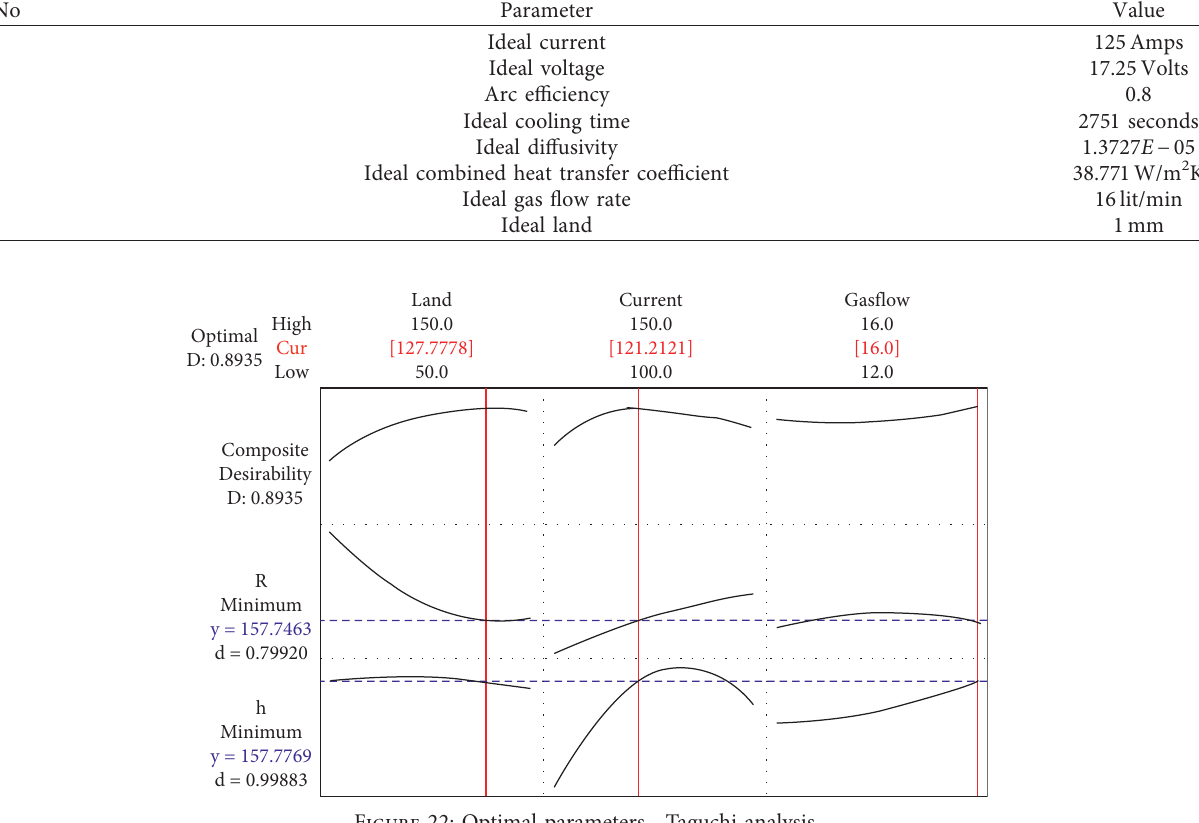
Table 18: Optimized values obtained from the mathematical model.